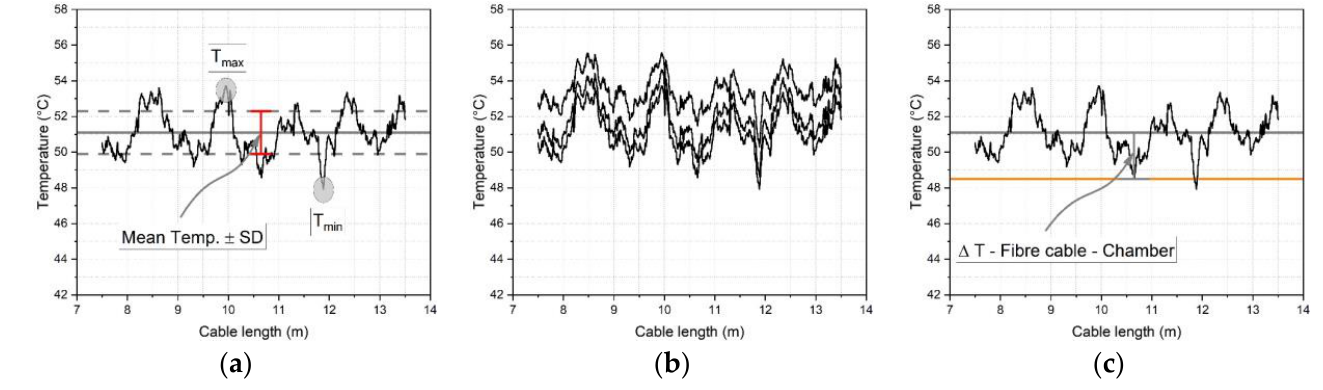
Figure 11. Length stability analysis, ( a ) fluctuations along the cable length, shown indicatively for the heating cycle ( b ) fluctuations for three selected times ( c ) averaging approach for a given sustained temperature.